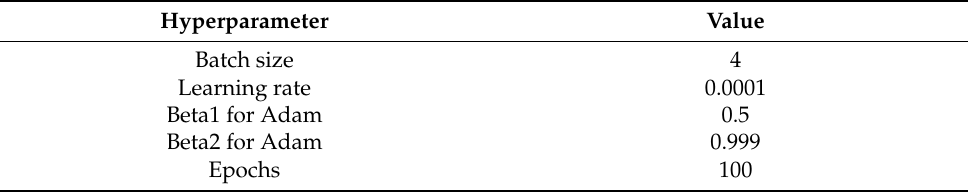
Table 3. Determination of hyperparameters for the U-Net-CBAM